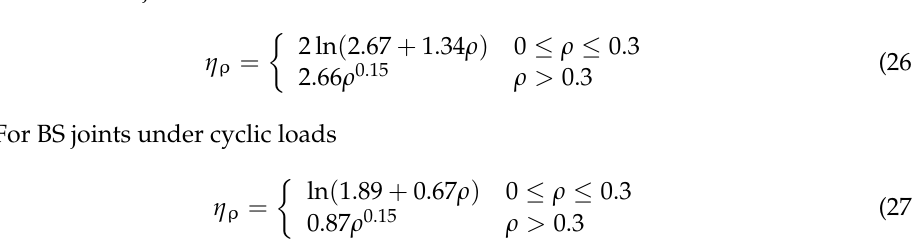
Table 8. Value of modification factor η lp .